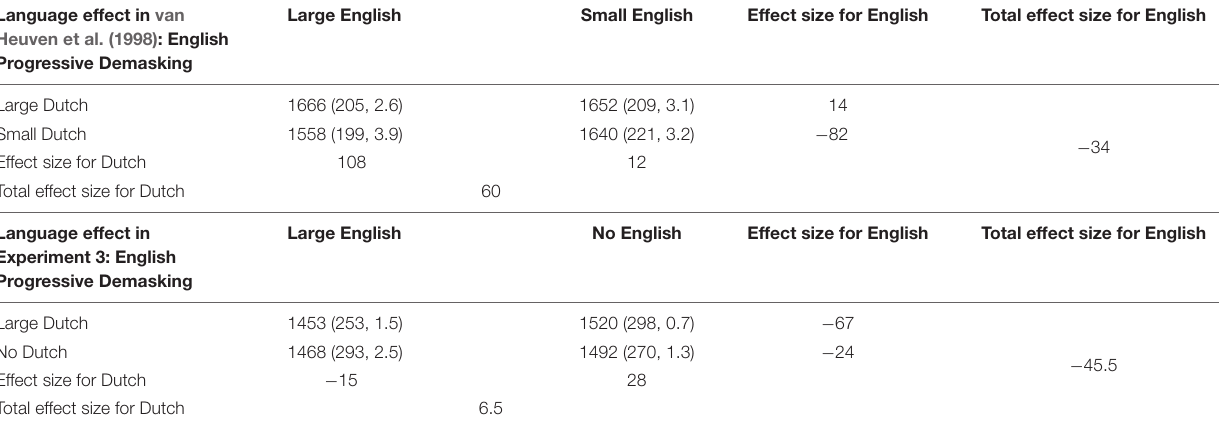
TABLE 8 | Mean RTs (in ms), standard deviations, error rates, and neighborhood effects for English word stimuli of blocked English Progressive Demasking in van Heuven et al. (1998, Experiment 1) and our Experiment 3 with hermits. Language effect in van Heuven et al. (1998): English